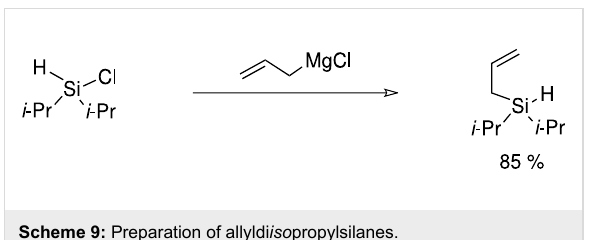
Scheme 9: Preparation of allyldi iso